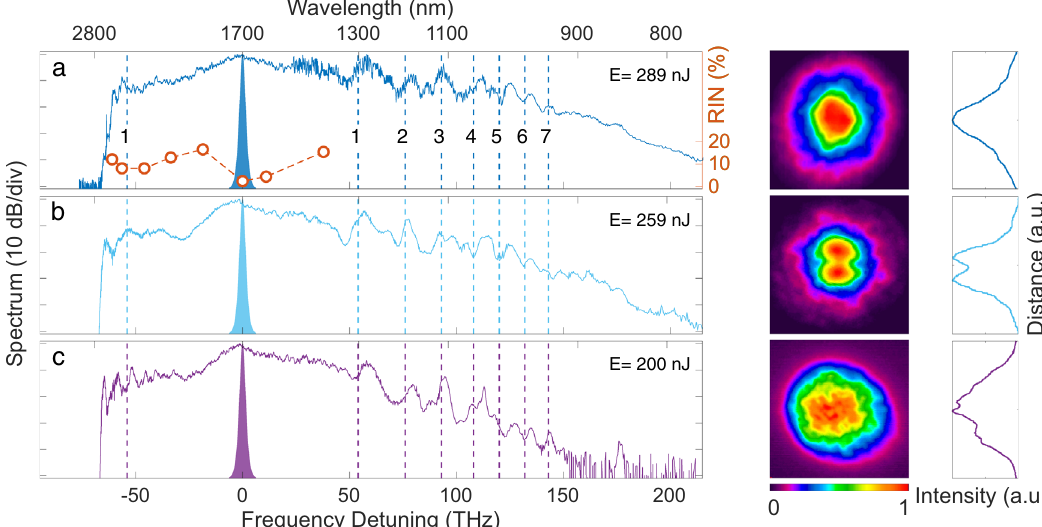
Fig. 3 Supercontinuum spectrum and spatial intensity distribution dependence on input beam tilt angle. Left panels: measured supercontinuum spectra at the output of the GRIN PBG fi ber with output pulse energy E indicated in each subplot. The input beam tilt angle is increased from a to c (see also main text). The vertical dotted lines correspond to the theoretical position of the GPI frequencies with order as shown. The red circles in sub-panel a show the relative intensity noise (RIN) measured for 4000 consecutive pulses in different wavelength bands with 6 nm bandwidth (see Methods). The RIN value of the input pulses at 1700 nm is 1%. Right panels: normalized far- fi eld spatial intensity distribution corresponding to the supercontinuum spectra shown in the left panels. The false-color plots show the 2D intensity distribution while the line plots show the intensity pro fi le along the vertical dimension. a.u: arbitrary